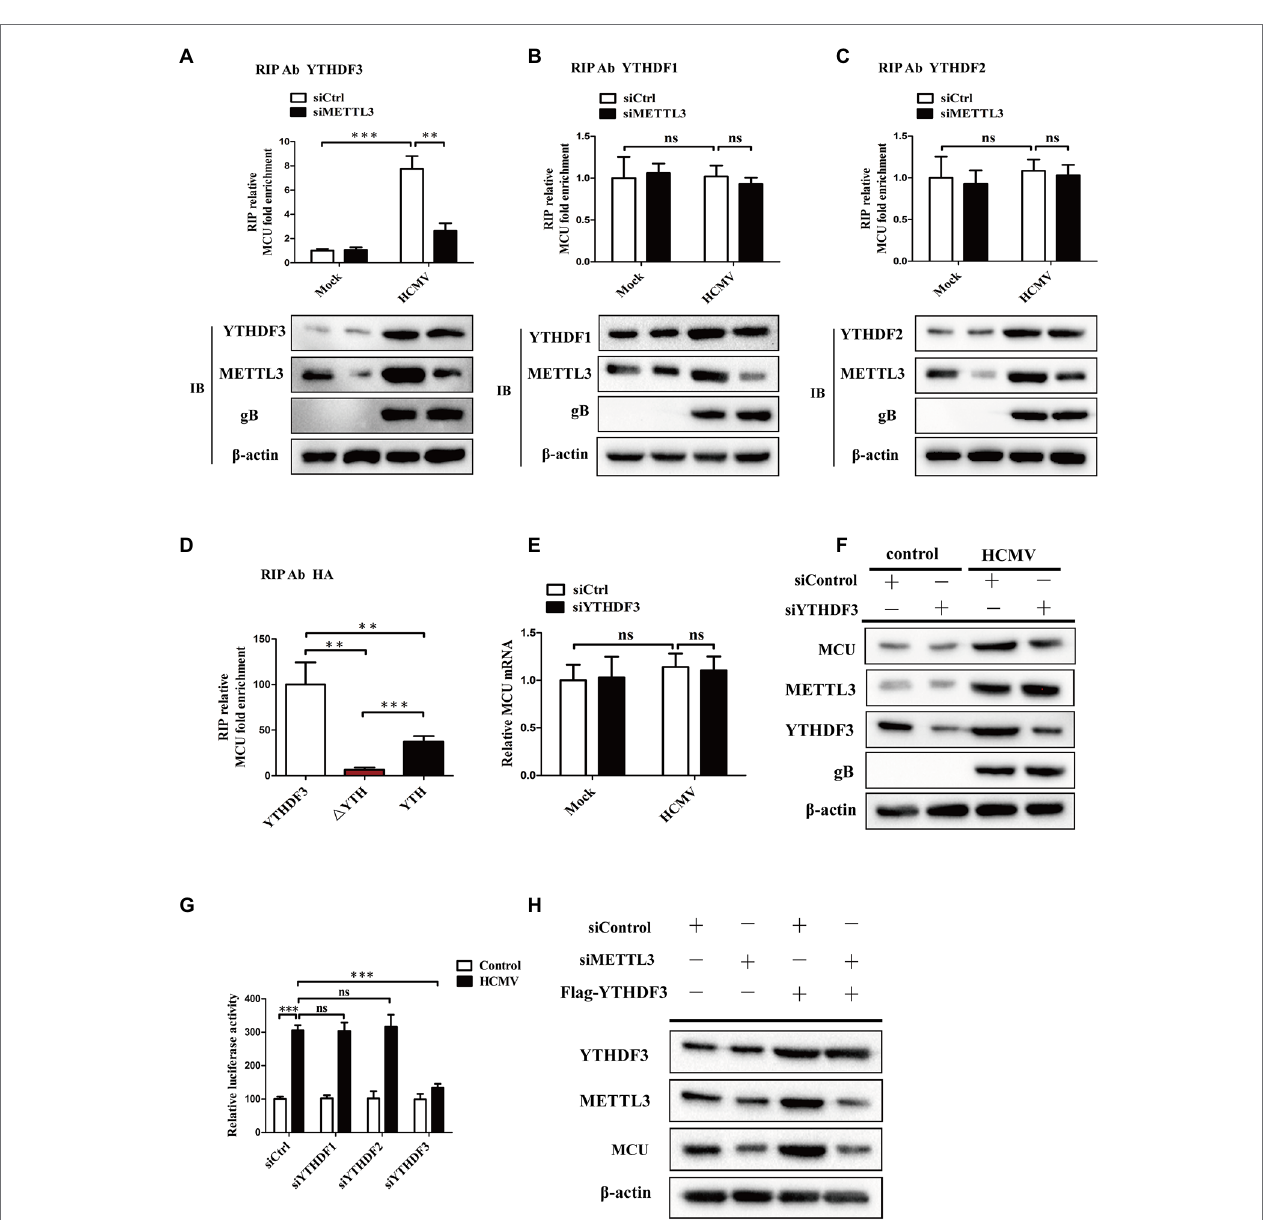
( Figure 6A ). In contrast, silencing METTL3 did not affect the association of YTHDF1 or YTHDF2 with MCU mRNA